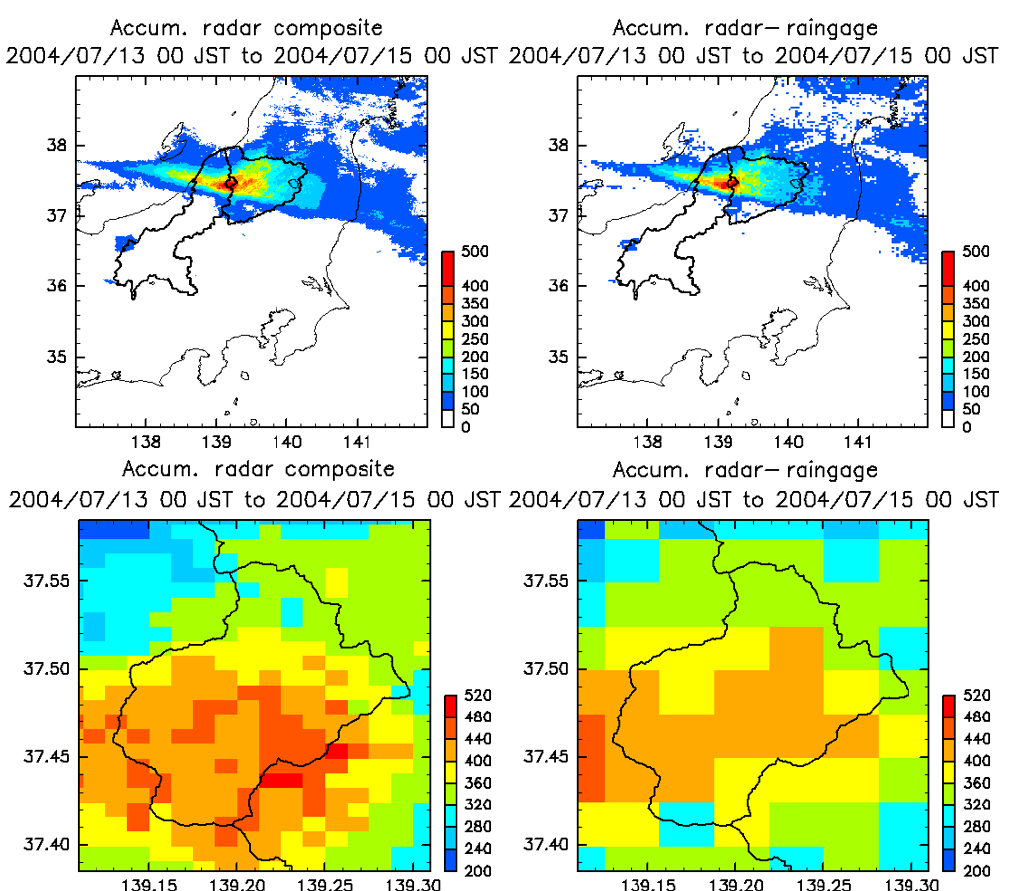
Figure 6. Spatial patterns of cumulative rainfalls around the Shinano and Agano catchments using radar composite (upper left) and radar–rain gauge (upper right) and around the Kasahori dam catchment using radar composite (lower left) and radar–rain gauge (lower right) for the 2004 rainfall